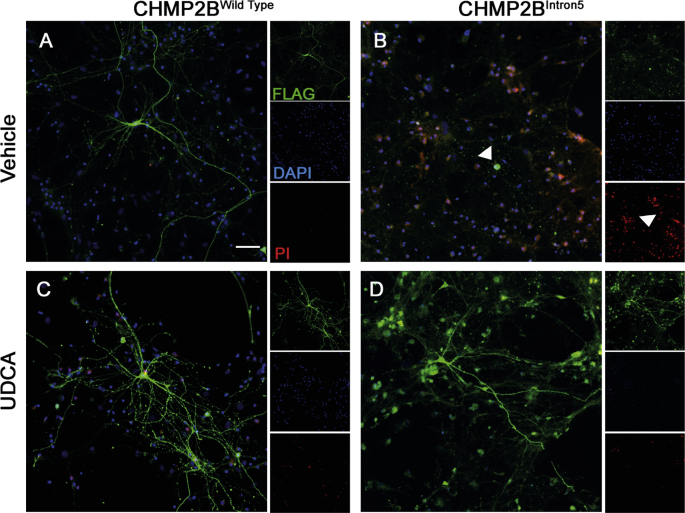
UCA Prevents CHMP2BIntron5 Induced Cell Death.A-D Representative micrographs of neurons expressing FLAG-tagged CHMP2BWildtype or CHMP2BIntron5 (FLAG, Green) ± UDCA (10 μM, 48 h) stained with propidium iodide (PI - red). Nuclei counterstained with DAPI (blue). Scale bar = 50 μm.